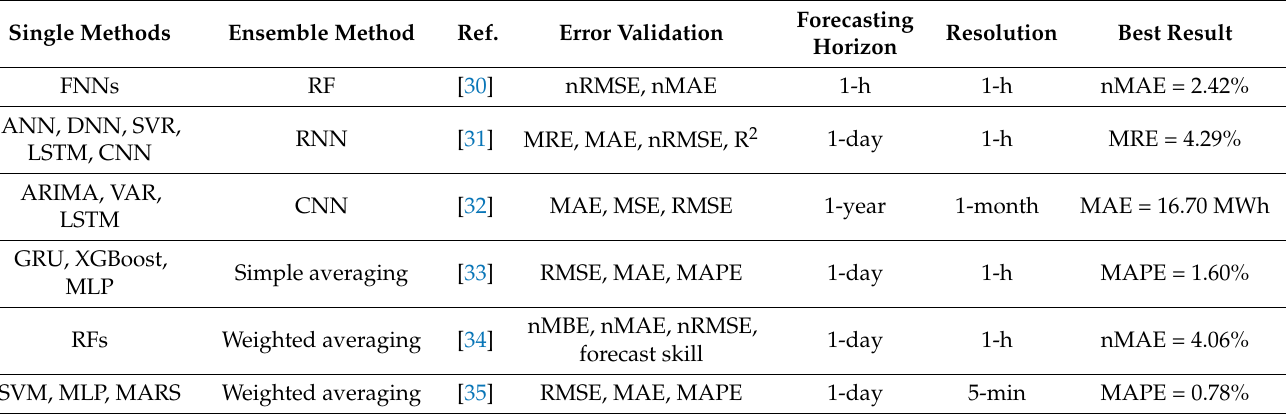
Table 1. The previous study of ensemble PV power